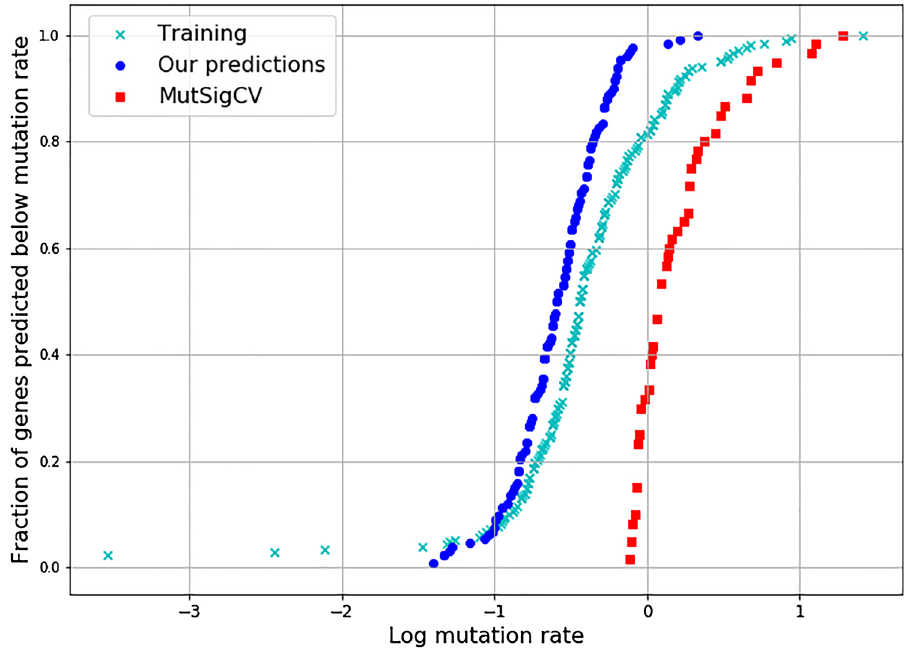
Figure 3. Fraction of genes predicted plotted against log transformed mutation rates. Genes predicted by a given method were sorted based on their mutation rate and plotted against the fraction of genes predicted below the given mutation